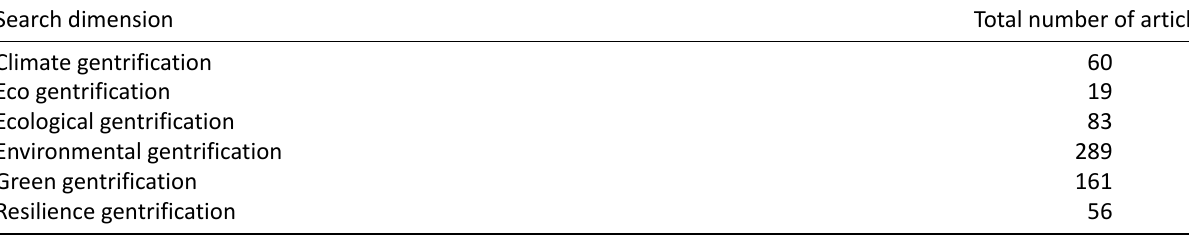
Table 1. Number of articles per search